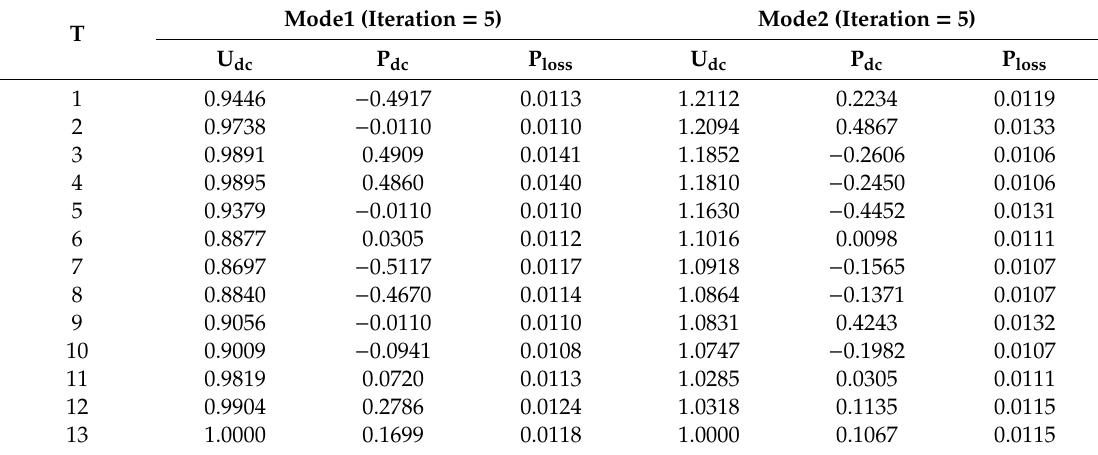
Table 6. Power flow calculation results with multi-point voltage control